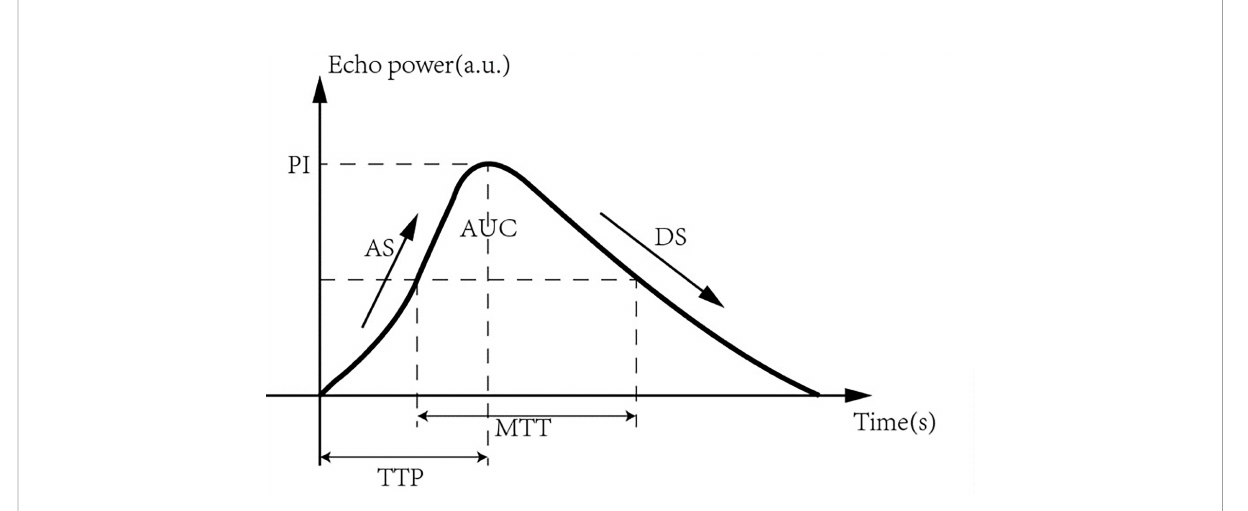
FIGURE 2 Time-intensity curve (TIC) of region of interest (ROI) generation in the lesion.